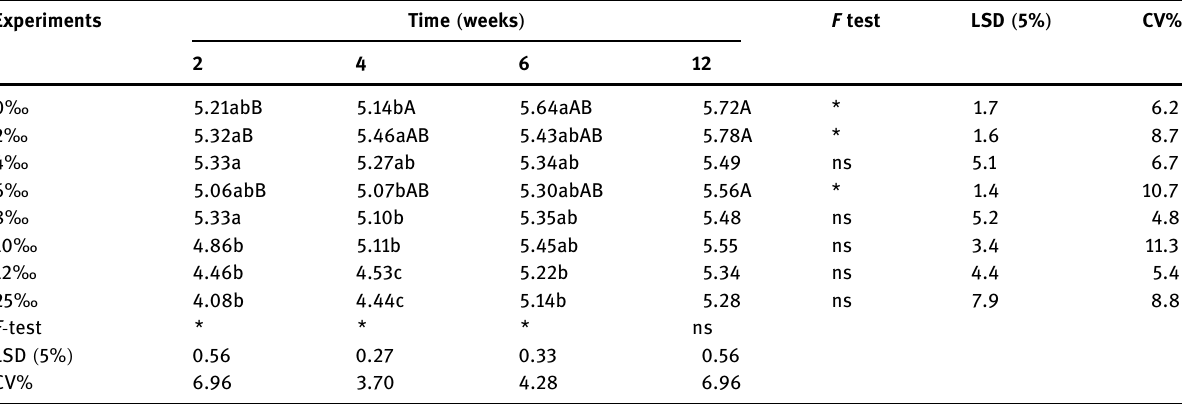
Table 4: Changes in soil pH over time due to saltwater intrusion and salt concentration Experiments